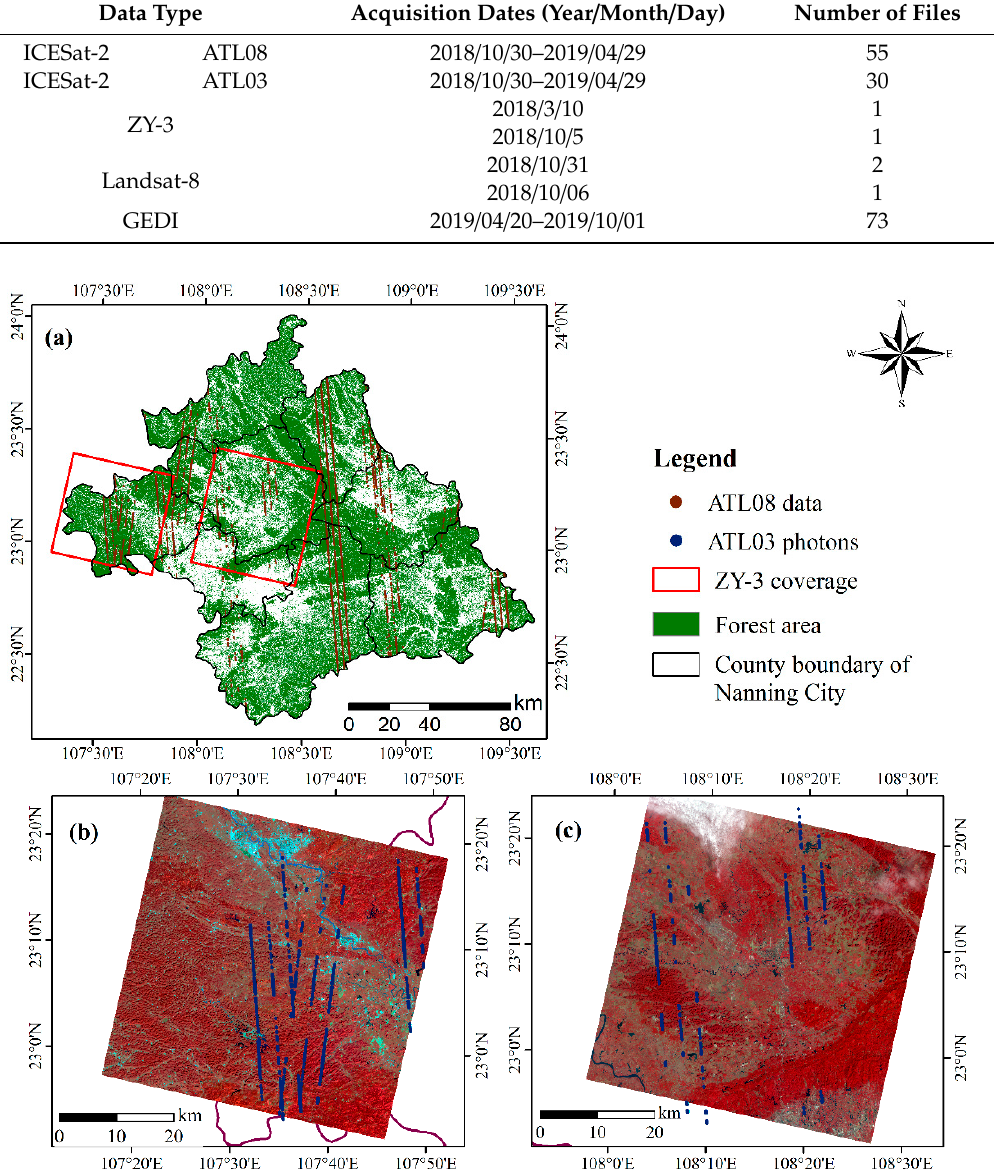
Table 1. Details of the ICESat-2, ZY-3, Landsat-8 and Global Ecosystem Dynamics Investigation Lidar (GEDI) satellite data.